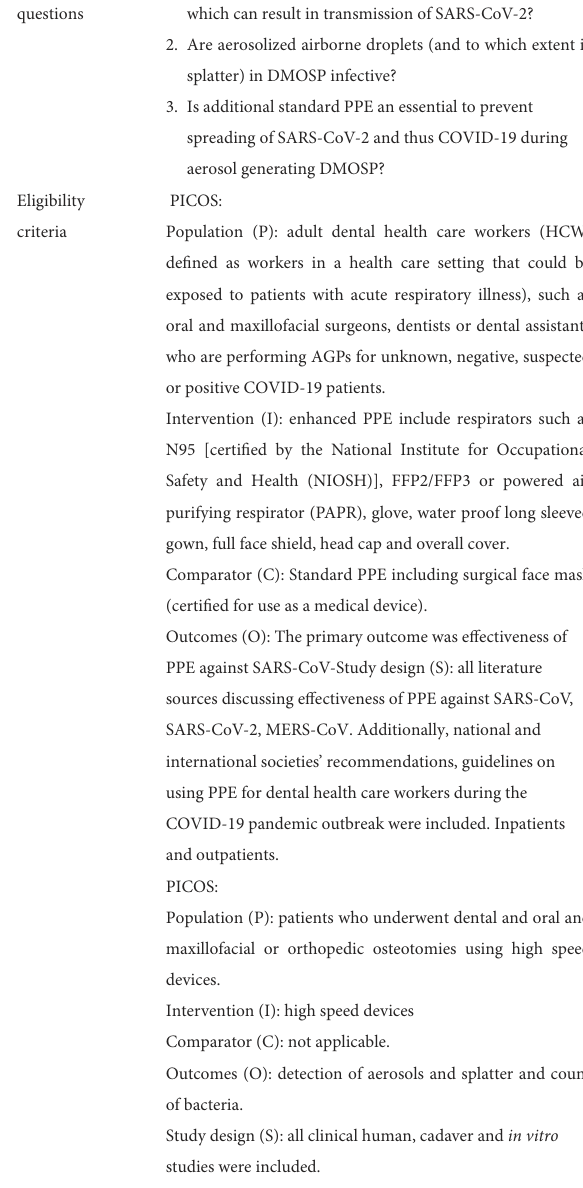
Figure 1 is a flowchart on the process of article evaluation for inclusion in the present systematic review. Based on the literature search, out of 131 articles assessed for eligibility, only 80 were included in the qualitative